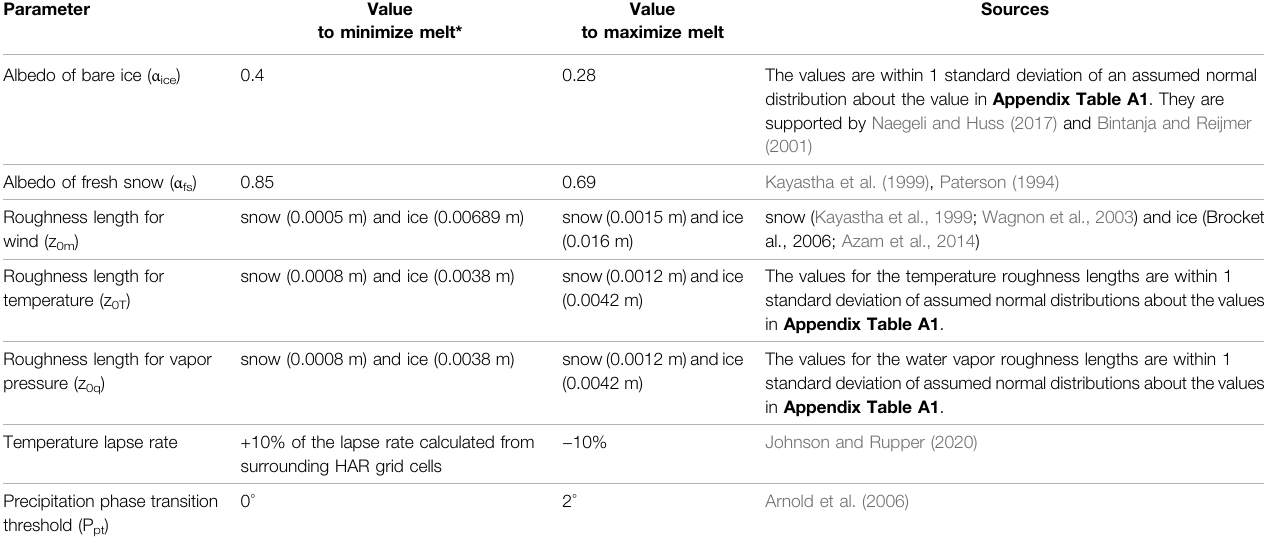
TABLE 3 | Values for the 10 parameters used in the uncertainty analysis. See Appendix Table A1 for the control values and their